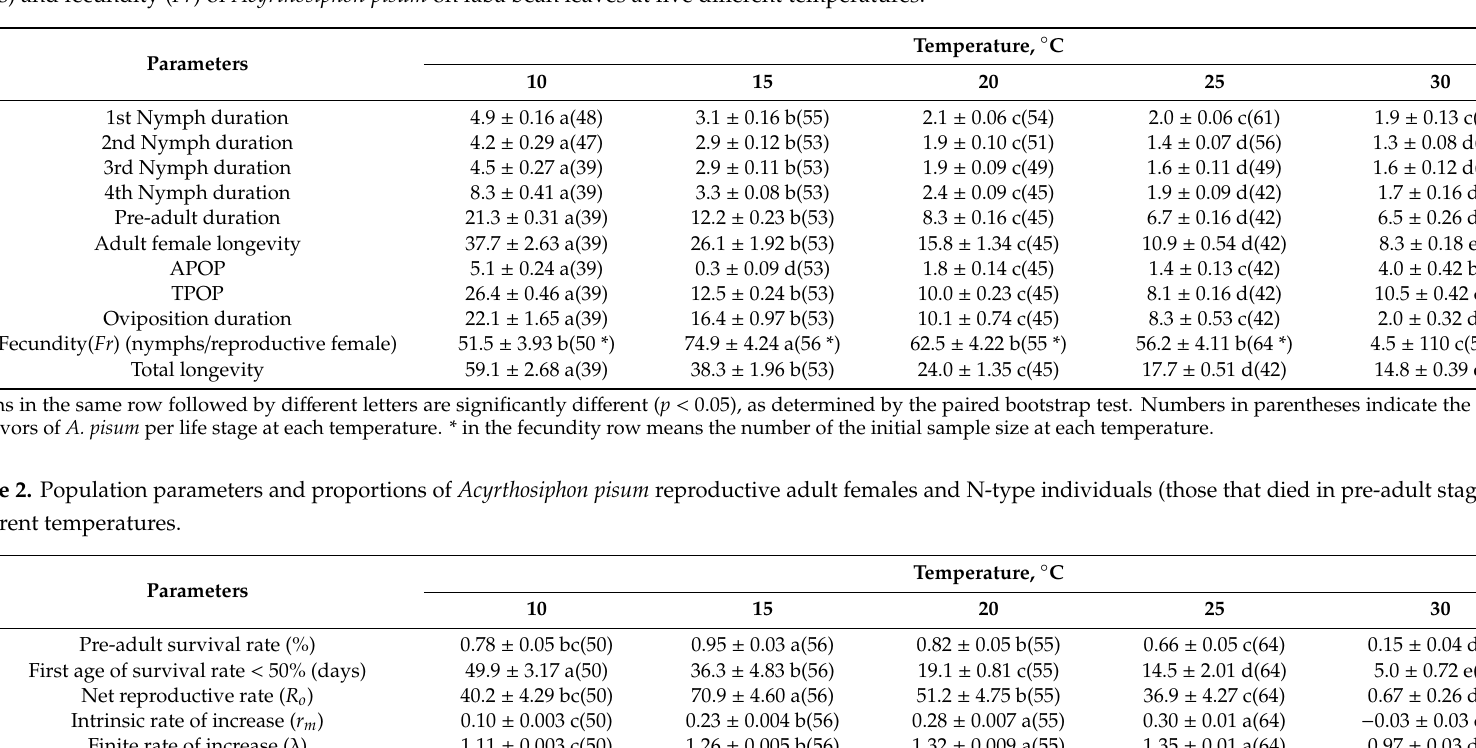
Table 1. Developmental time (days), longevity (days), APOP (adult pre-oviposition period, days), TPOP (total pre-oviposition period, days), oviposition duration (days) and fecundity ( Fr ) of Acyrthosiphon pisum on faba bean leaves at five di ff erent temperatures.